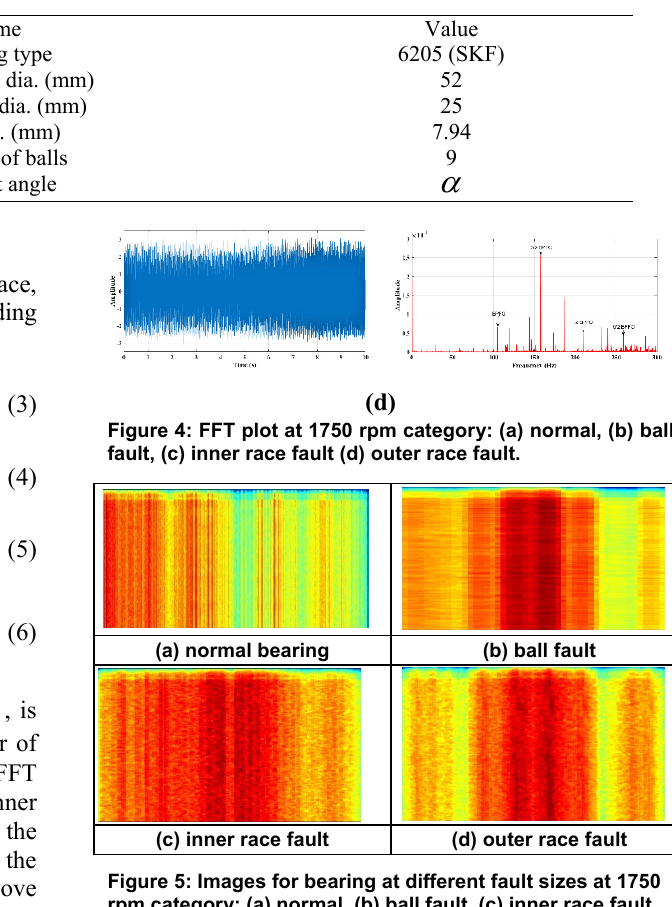
Figure 5: Images for bearing at different fault sizes at 1750 rpm category: (a) normal, (b) ball fault, (c) inner race fault (d) outer race